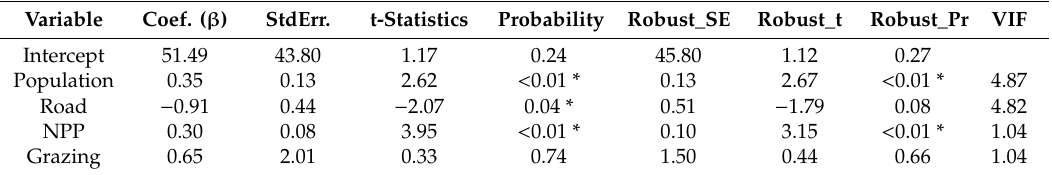
Figure 4. Distribution of selected explanatory variables for the reduced carbon uptake (RCU) from vegetation. ( a ) Grazing intensity, ( b ) Population density, ( c ) Road network density, and ( d ) Net primary productivity (NPP) at the administrative unit level. Table 2. Statistics of the regression coe ffi cient for the explanatory variables from ordinary least square (OLS)